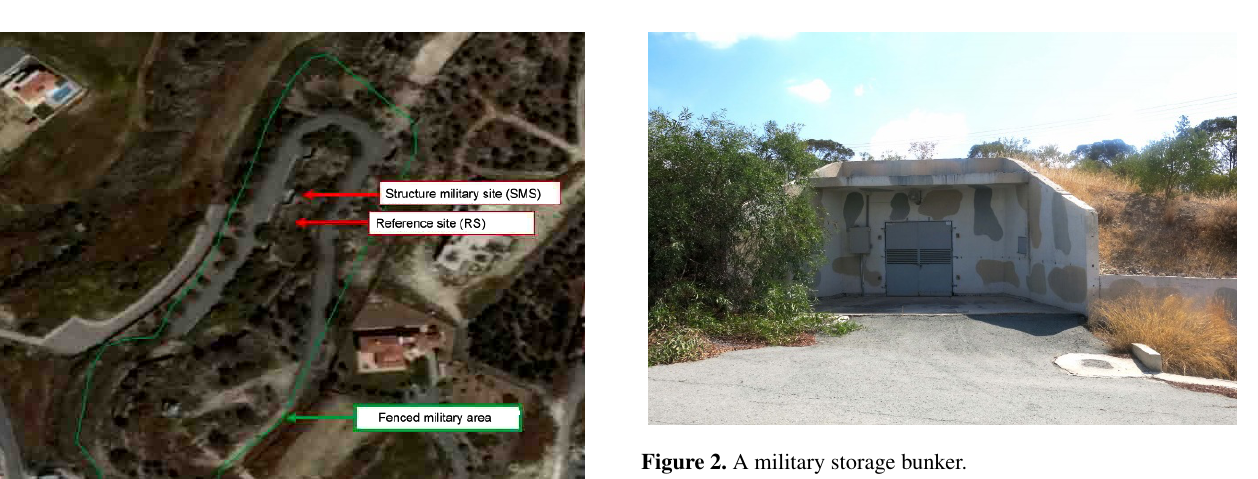
Figure 2. A military storage